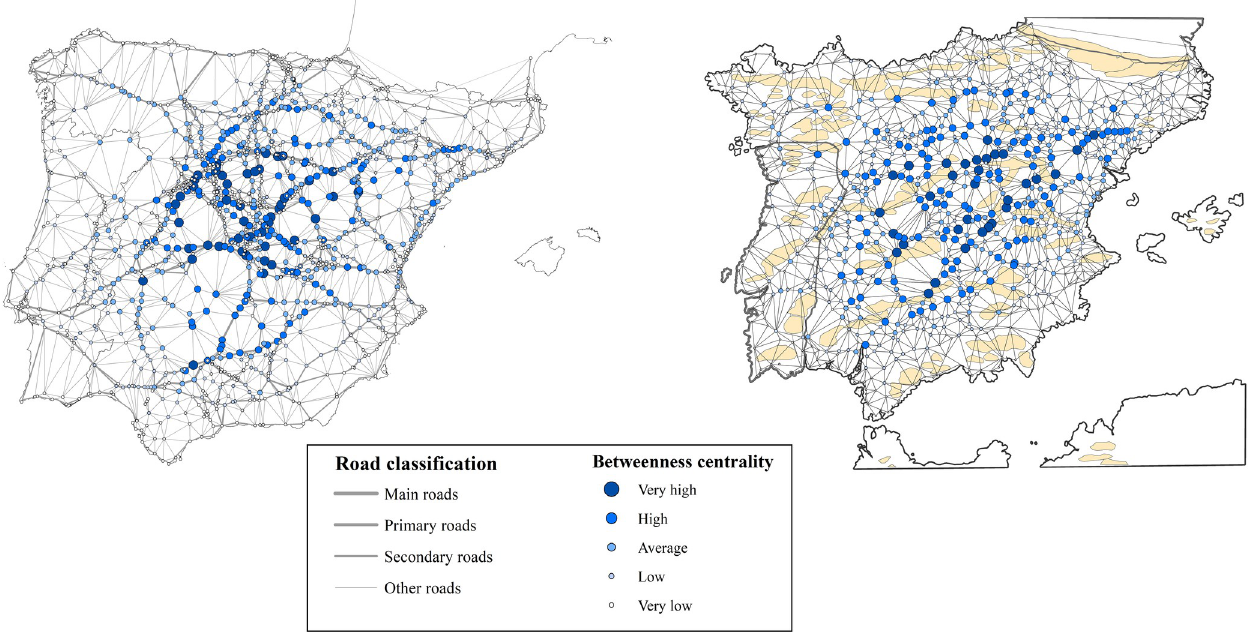
Fig 12. Betweenness centrality maps. Notes : The calculation of betweenness centrality does not consider road categories because they refer more to aspects of traffic than to the technical characteristics of roads. The length of the sections and their slope were included. Source : Produced by the authors from the networks shown in Figs 10 and 11. Base map from the Centro Nacional de Informacio´n Geogra´fica (Spain).